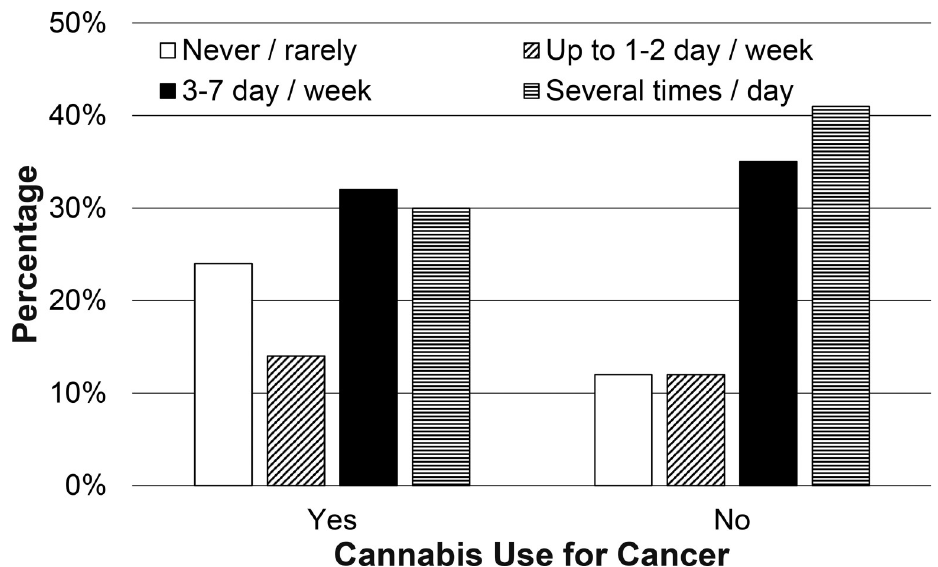
Fig 1. Frequency of medical Cannabis use. Reported frequency of Cannabis use for those who did and did not endorse cancer diagnosis.